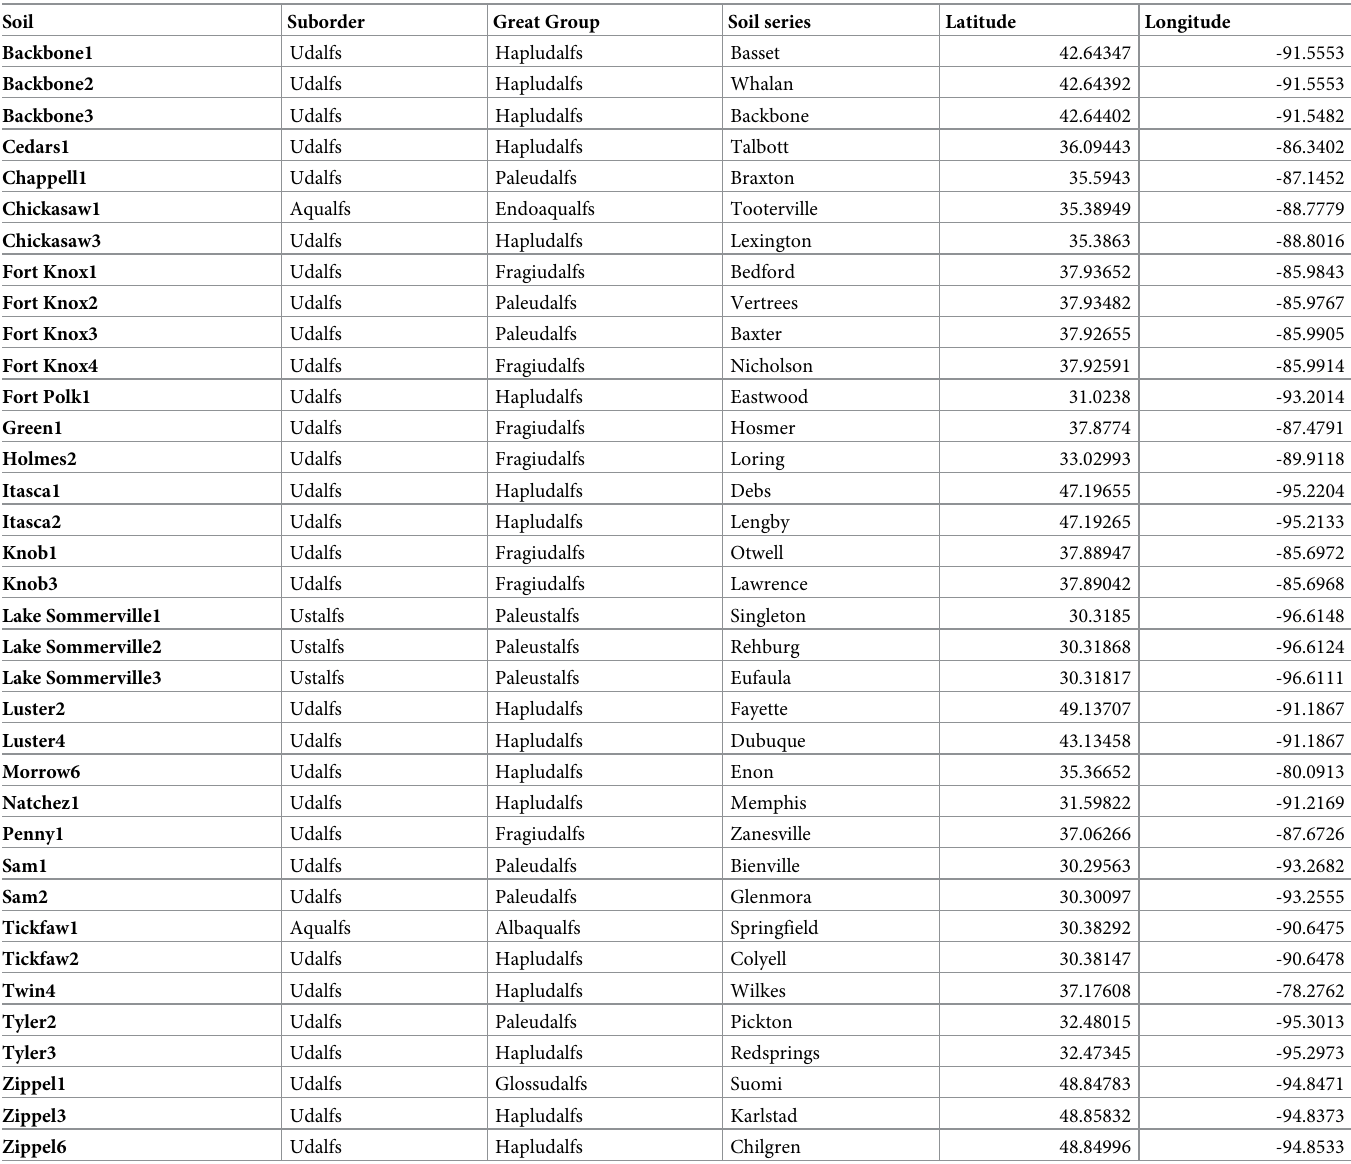
Table 1. Samples collected including soil type and geographical coordinates of the